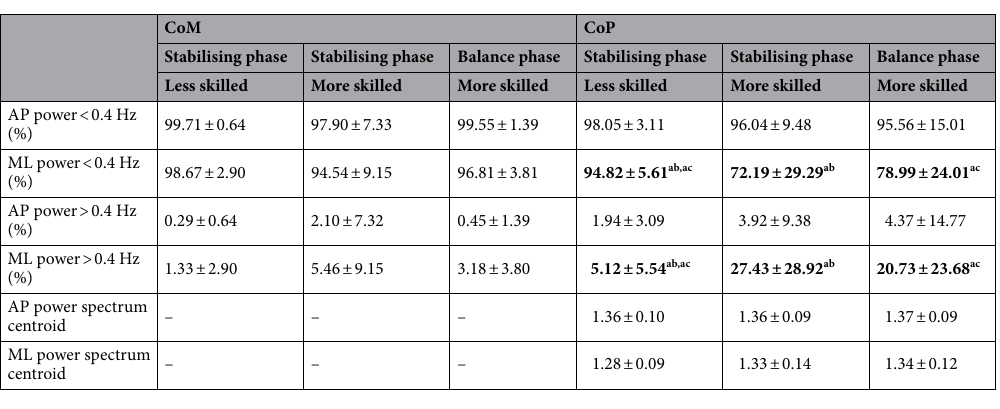
Table 2. Frequency domain power < and > 0.4 Hz and power spectrum centroid for CoM and CoP mean ± S.D. for each group. Bold values indicates a significant difference between two or more conditions ( P < 0.05). ab P < 0.05 between less and more skilled stabilising phase (independent t-test). ac P < 0.05 between less skilled stabilising phase and more skilled balance phase (independent t-test).